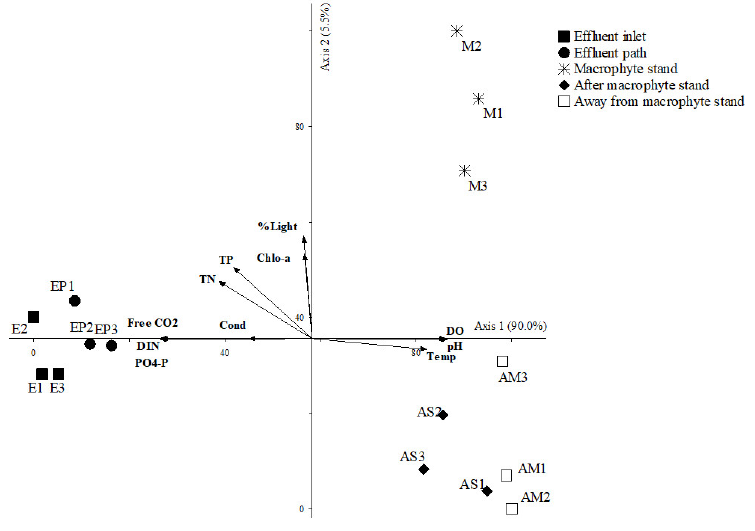
Figure 3. PCA of environmental variables in the sampling sites. Abbreviations: the letters indicate the sampling sites (E, effluent inlet; EP, effluent path; M, inside macrophyte stand; AS, after 1 m from the macrophyte stand; AM, 10-15m away from the macrophyte stand), and the last number indicates the three replicates (1,2,3) from each sampling